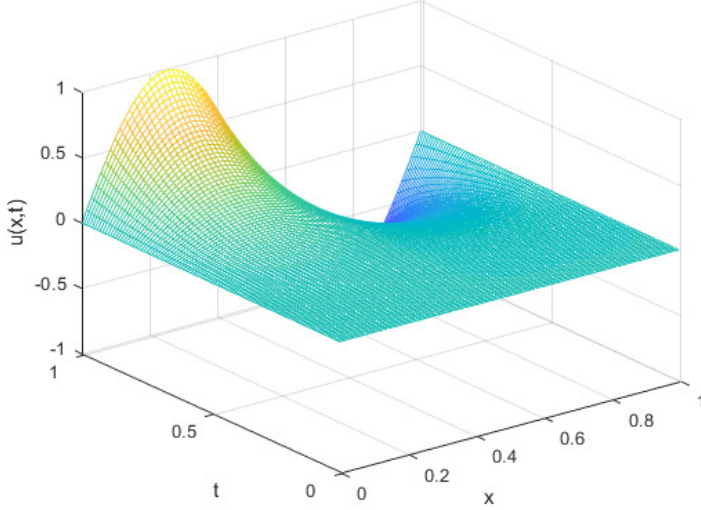
Figure 3. C-N scheme solution surface for Example 1. ( α = 0.7).